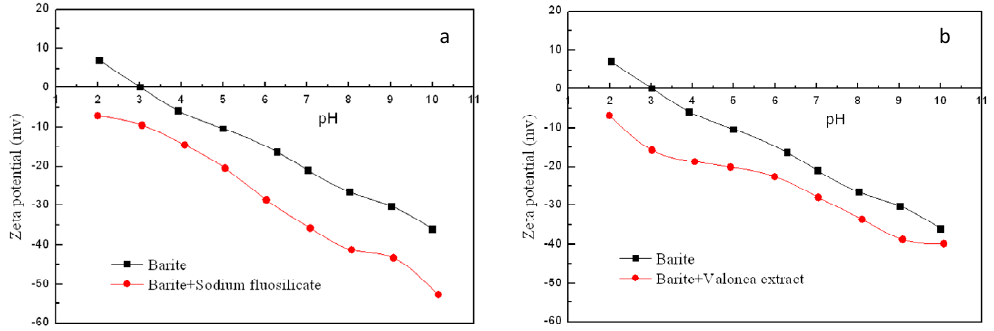
Figure 9. Effect of addition of sodium fluosilicate ( a ) and valonea extract ( b ) on the zeta potential of barite (sodium fluosilicate dosage = 3 × 10 − 5 mol/L, valonea extract dosage = 4 × 10 − 4 g/L).